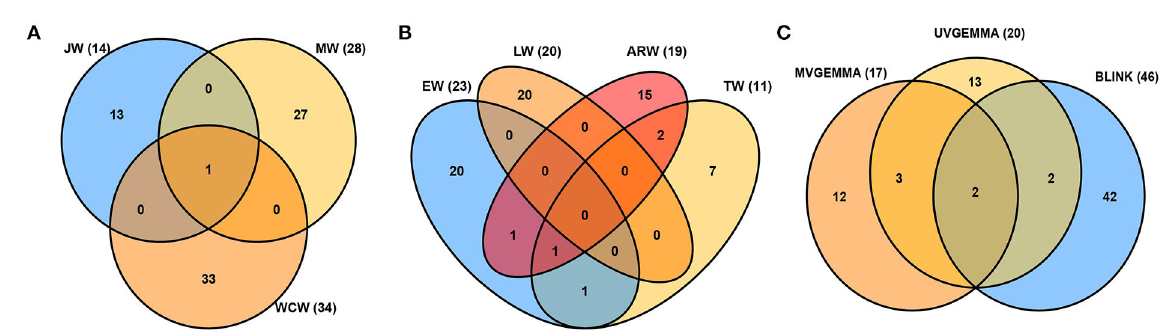
Table 3; Supplementary Table S7), which is homologous to an Arabidopsis BAM3 with a proposed function in cold response (Monroe et al.,